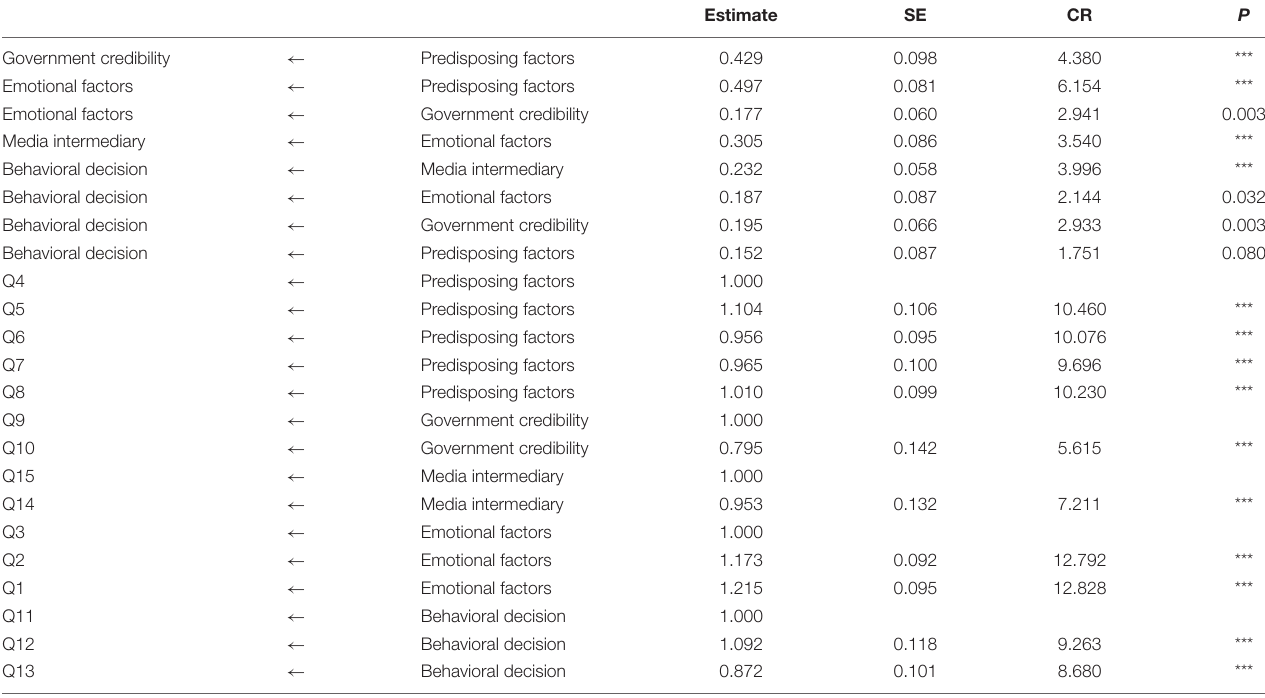
TABLE 4 | Path coefficient estimation and parameter significance of the initial model.